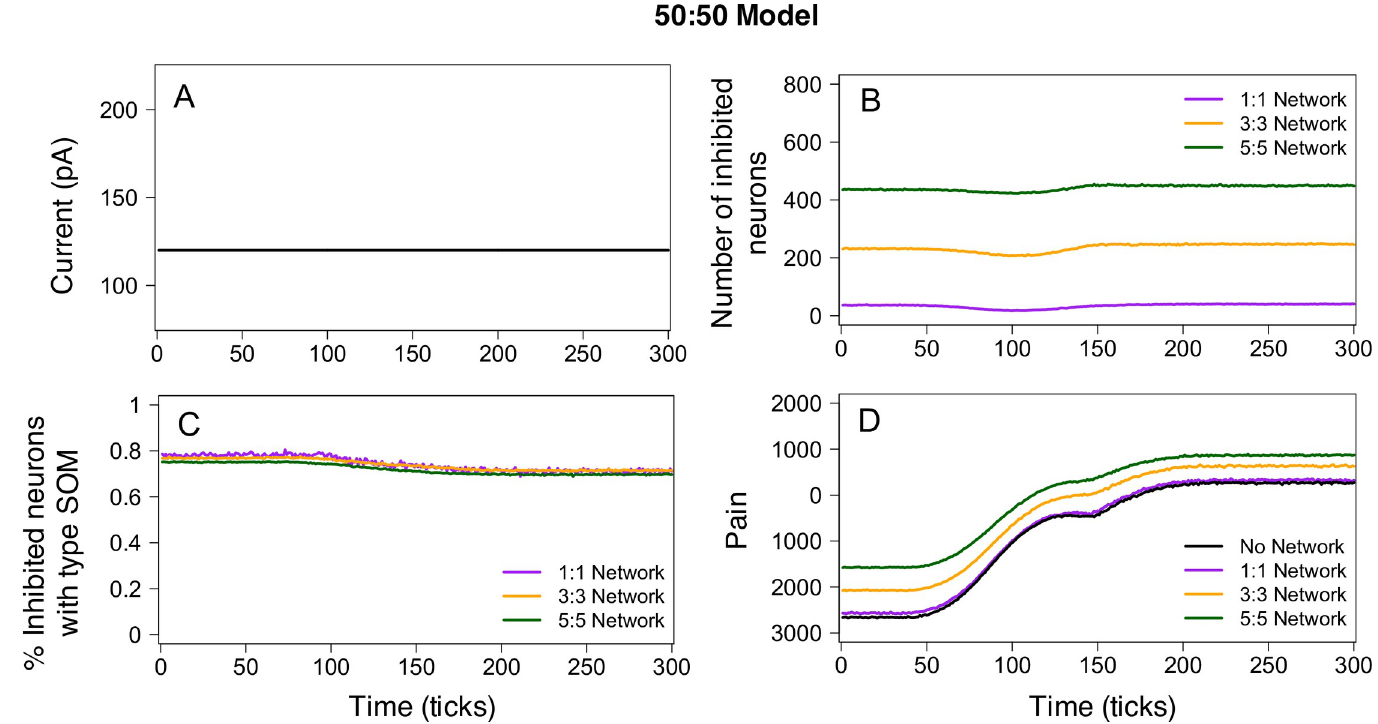
Fig 4. 50:50 model output for different network parameters. Simulations of the 50:50 model were performed for four different connectivity networks: No network, 1:1 network, 3:3 network, and 5:5 network. In all simulations, we assumed a constant 120 pA current ( A ). The total number of inhibited neurons ( B ) and pain output ( D ) varied across the different network structures. However, the percentage of inhibited neurons that are SOM was similar for the 1:1, 3:3, and 5:5 networks ( C ). In simulations with no network, there are no inhibited neurons and the pain output closely resembles pain output from the 1:1 model.